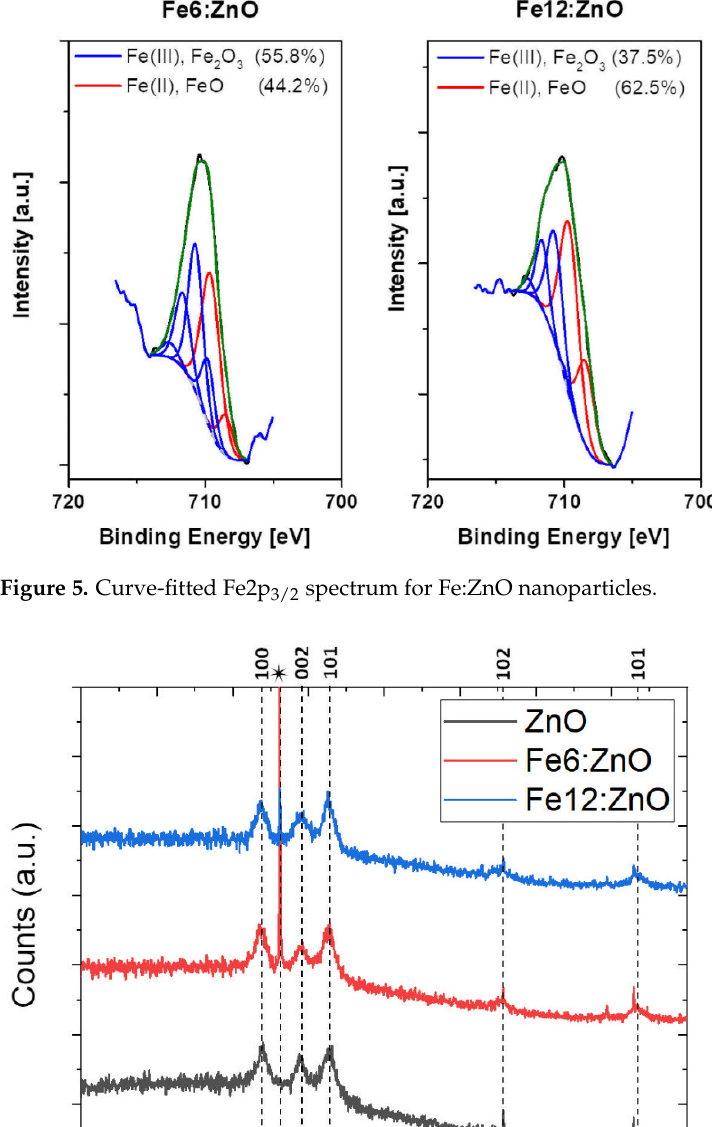
Figure 6. X-ray diffraction patterns of ZnO, Fe6:ZnO and Fe12:ZnO NPs. * refers to the silicon wafer used as substrate. used as